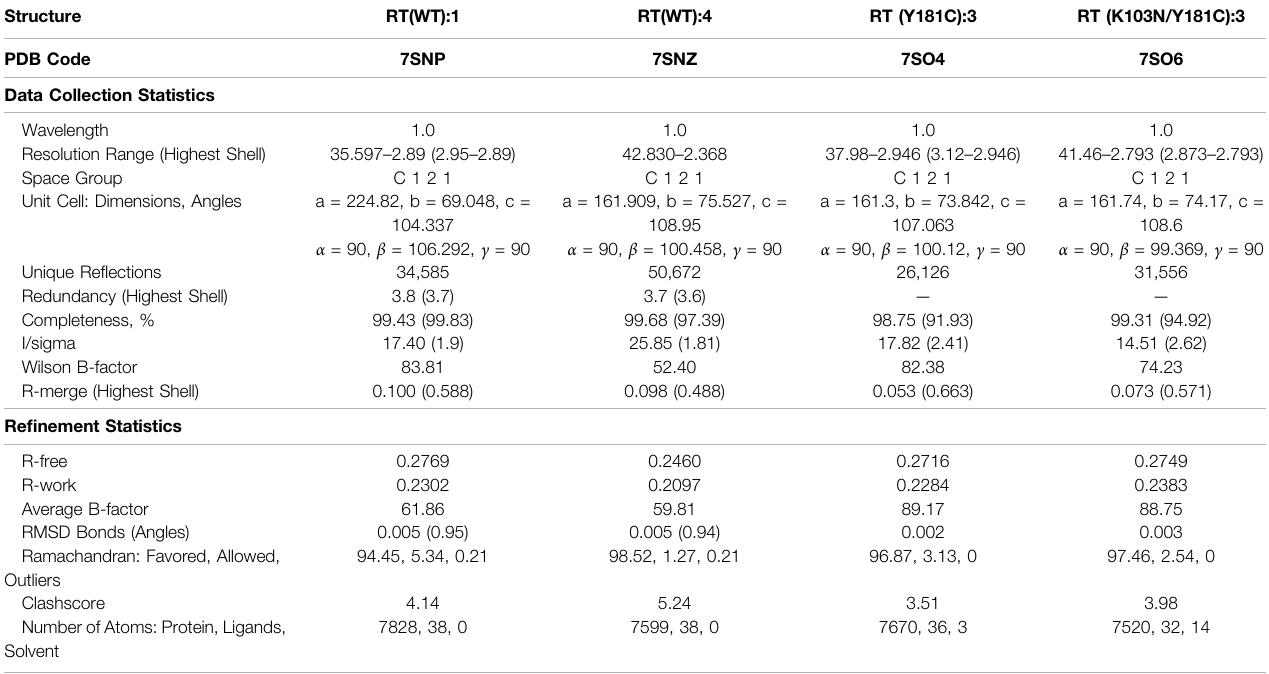
TABLE 3 | Data collection and re fi nement statistics for RT (WT) crystal structures in complex with compounds 1 and 4, RT (Y181C) with compound 3, and RT (K103N/ Y181C) with compound 3 .